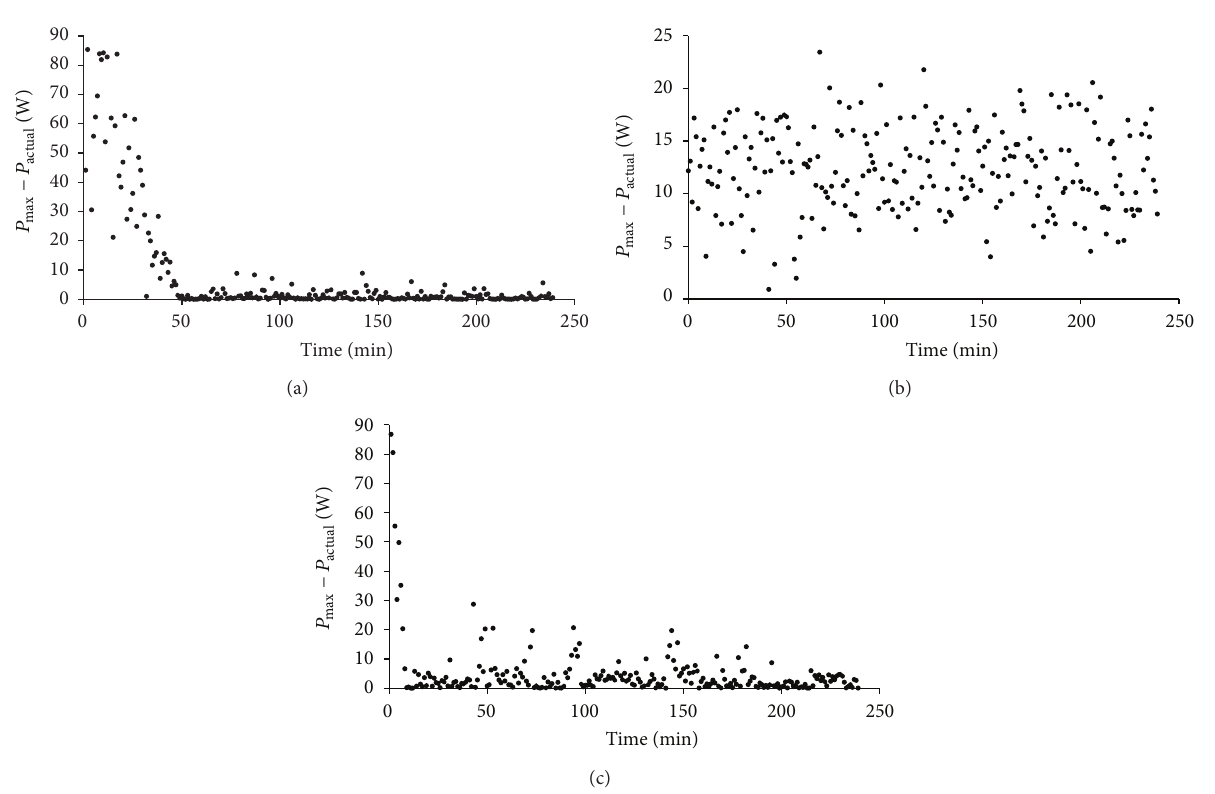
Figure 10: The maximum power point minus the predicted current power point corresponds to the same sensing time: (a) P&O method, (b) open-circuit voltage method, and (c) RLMPPT method.